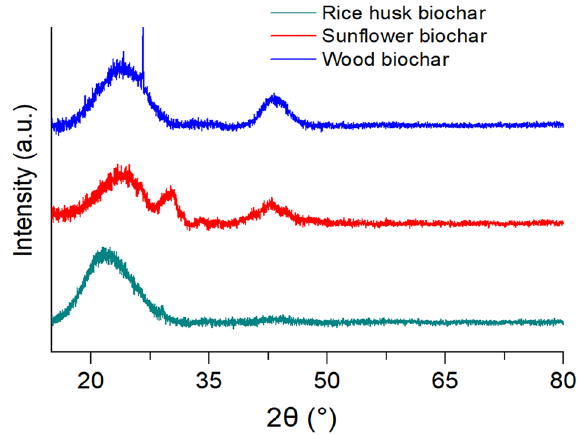
Figure 1. XRD spectra of biochars from various raw